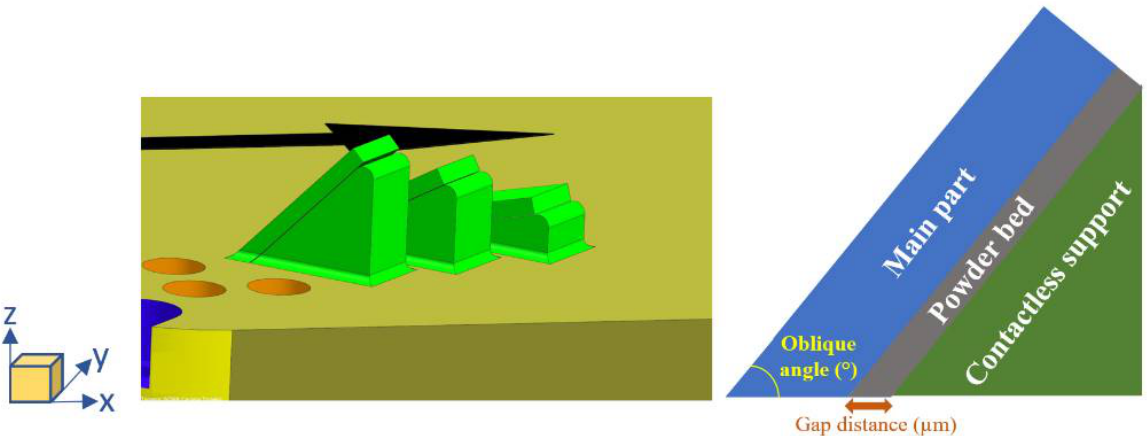
Figure 1. Representative sample design.